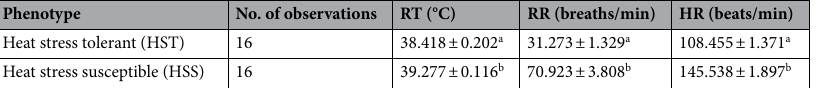
Table 2. Mean of physiological responses (RT, RR and HR) in heat stress-tolerant and heat stress-susceptible phenotype in Jamunapari goats during heat stress period. No Number or sample size; RT Rectal temperature in degree centigrade (°C); RR Respiration rate (breaths/per min); HR Heart rate (beats/per min), Means ± SE means within the same rows with different superscripts are significantly different ( p <